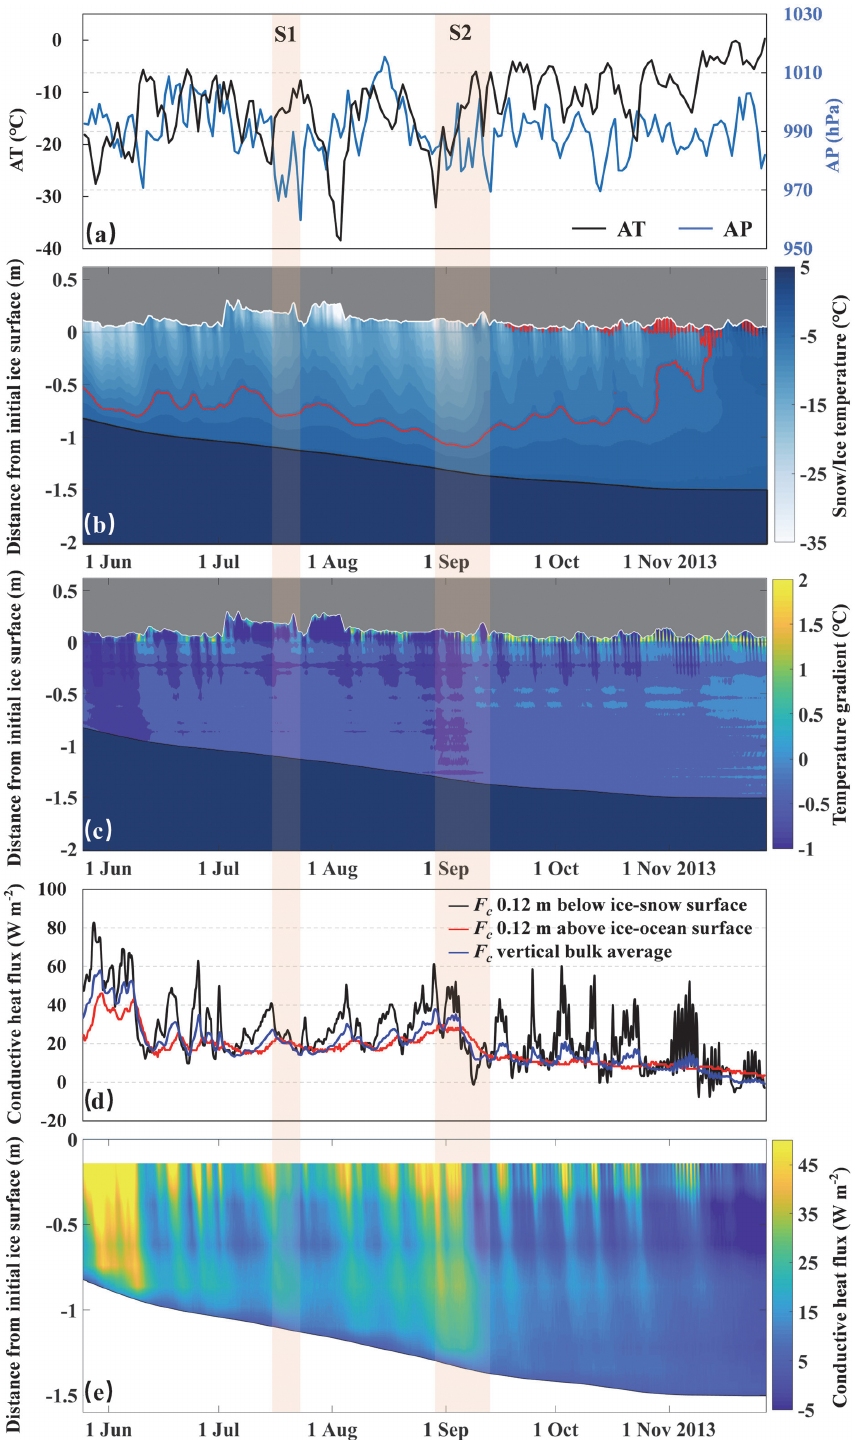
Figure 6. (a) Time series of the AT and AP; (b) snow and sea ice temperatures, with the white, red, and black lines representing the snow surface, the − 5 ◦ C isotherm, and the ice bottom, respectively; (c) snow and sea ice temperature gradients; (d) conductive heat flux through the ice; and (e) conductive heat flux through the ice at ZS2013a. On the vertical axes of panels (b) , (c) , and (e) , the zero line refers to the initial snow–ice interface. The shaded areas represent periods experiencing two typical warming events of S1 and S2.